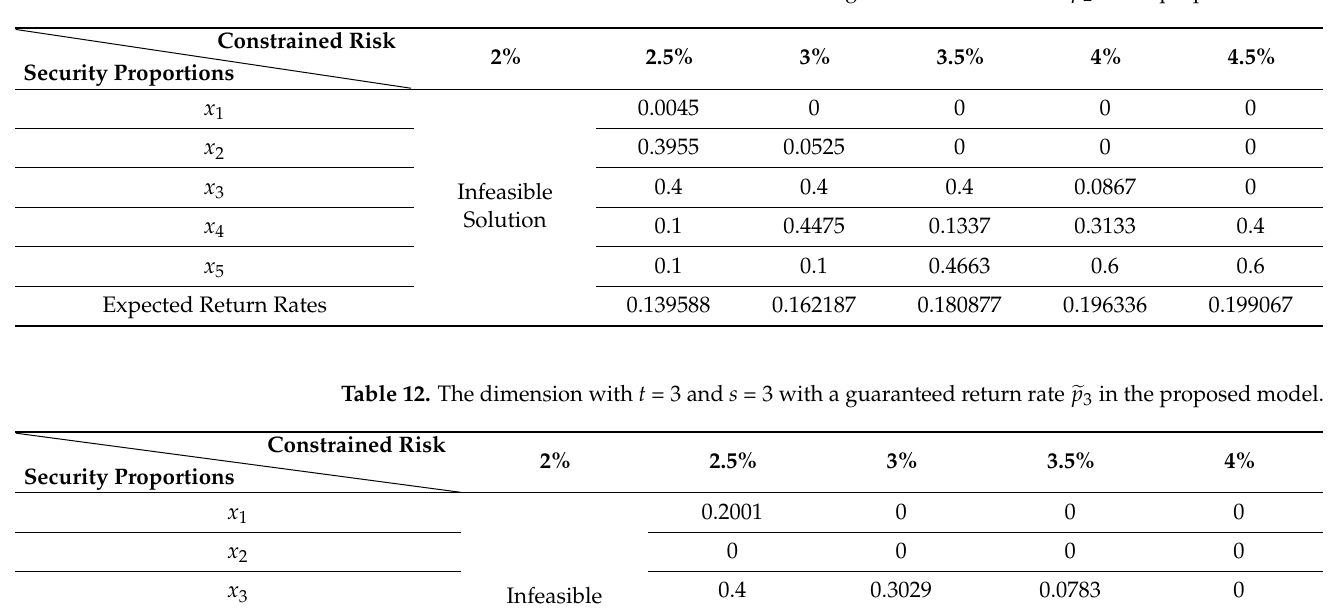
Table 11. The dimension with t = 3 and s = 3 with a guaranteed return rate (cid:101) p 2 in the proposed model.